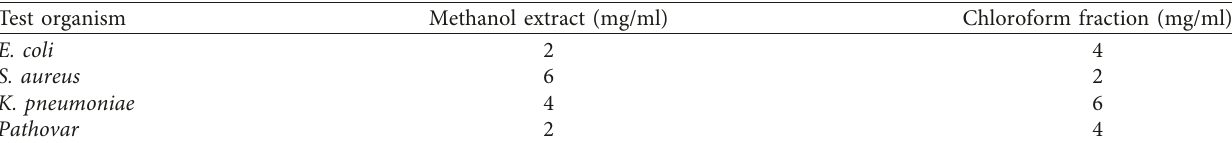
Table 2: MIC values (gm/ml) of the antibacterial activity of methanol extract and chloroform fraction of N. distans . Test organism